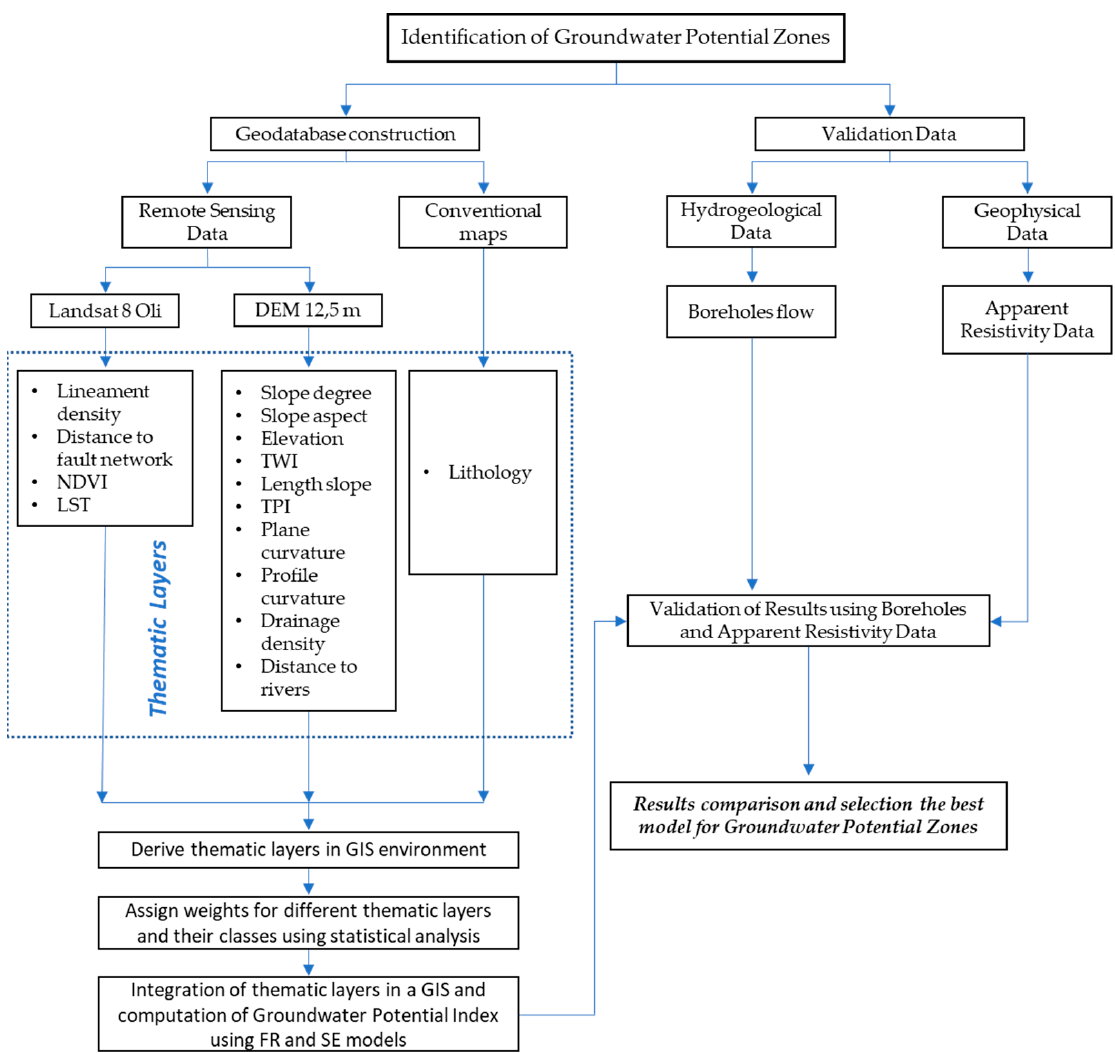
Figure 6. Flowchart shows the role of all spatial data and techniques incorporated in this study.